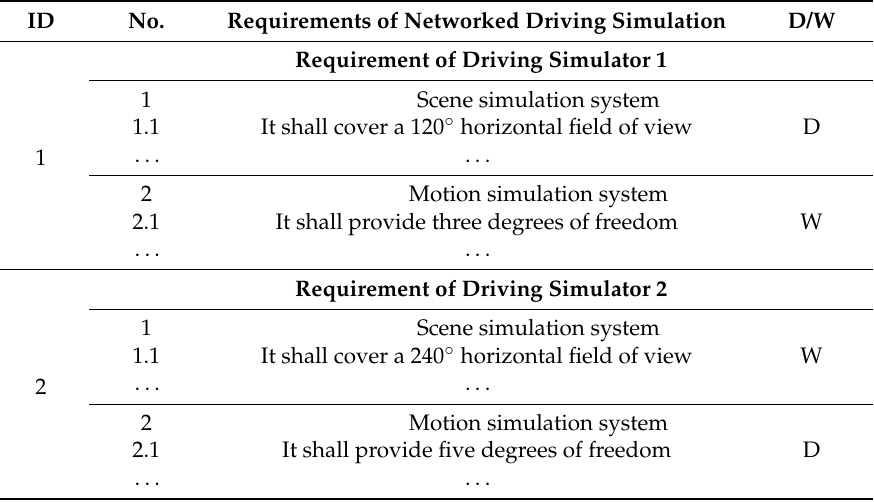
Table 7. Example list of requirements of a networked driving simulation system